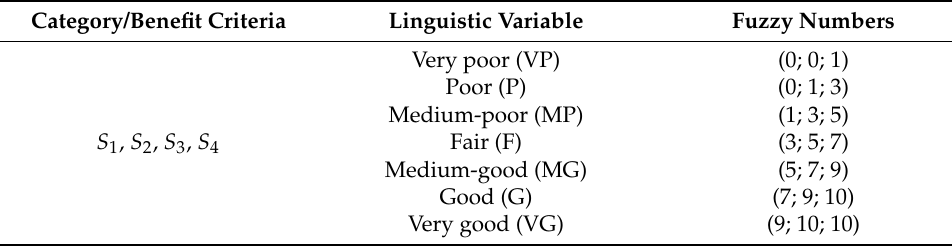
Table 5. Linguistic variables for the ratings.